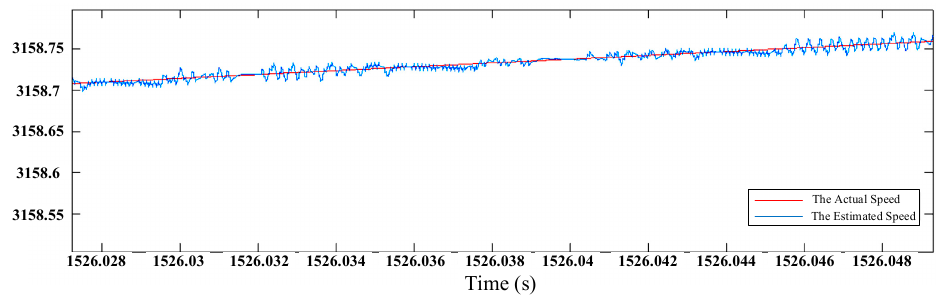
Figure 10. The enlarged part of the speed waveform.